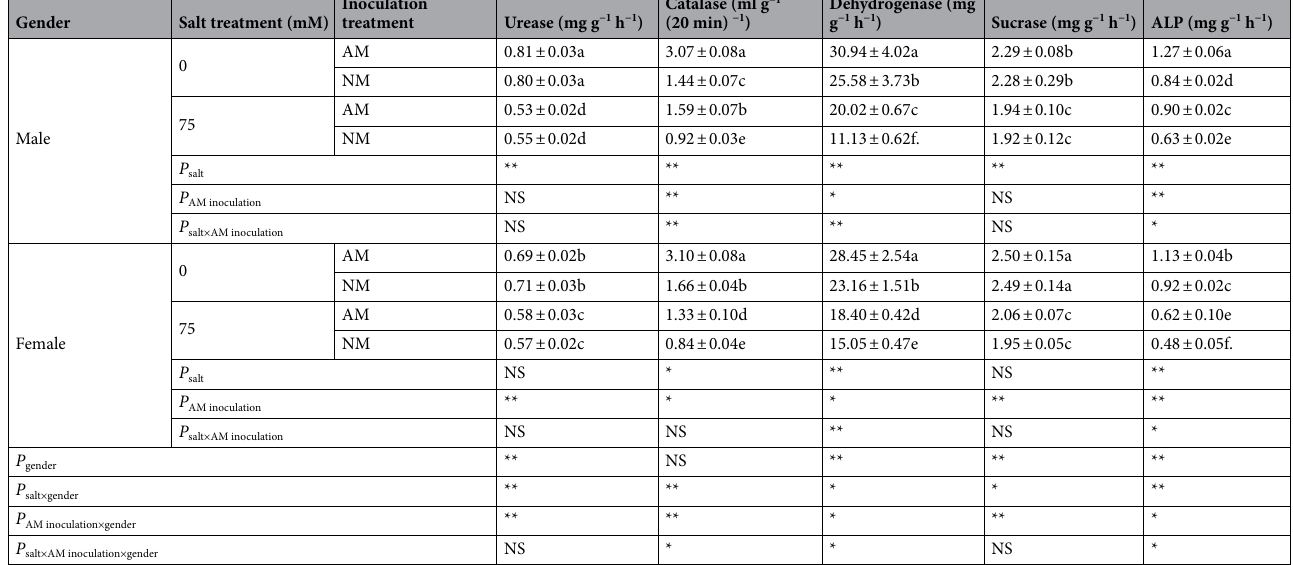
Table 4. Effects of AMF inoculation on the soil enzyme activities in the rhizosphere of P . cathayana males and females under different salt conditions. AM, AMF inoculation; NM, non-inoculation. Different normal letters in the same column mean 5% significant